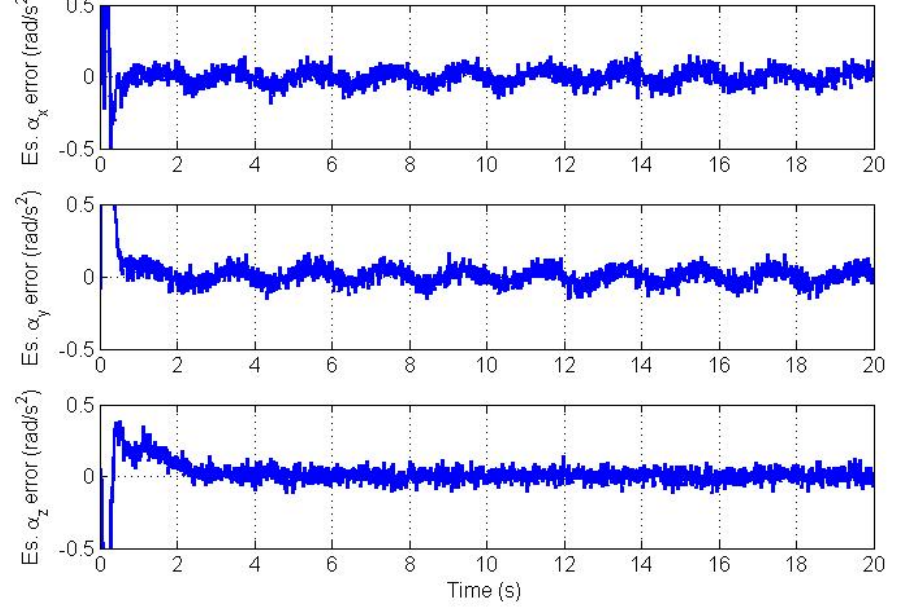
Figure 8. Angular acceleration vector estimation errors for improper initialization.